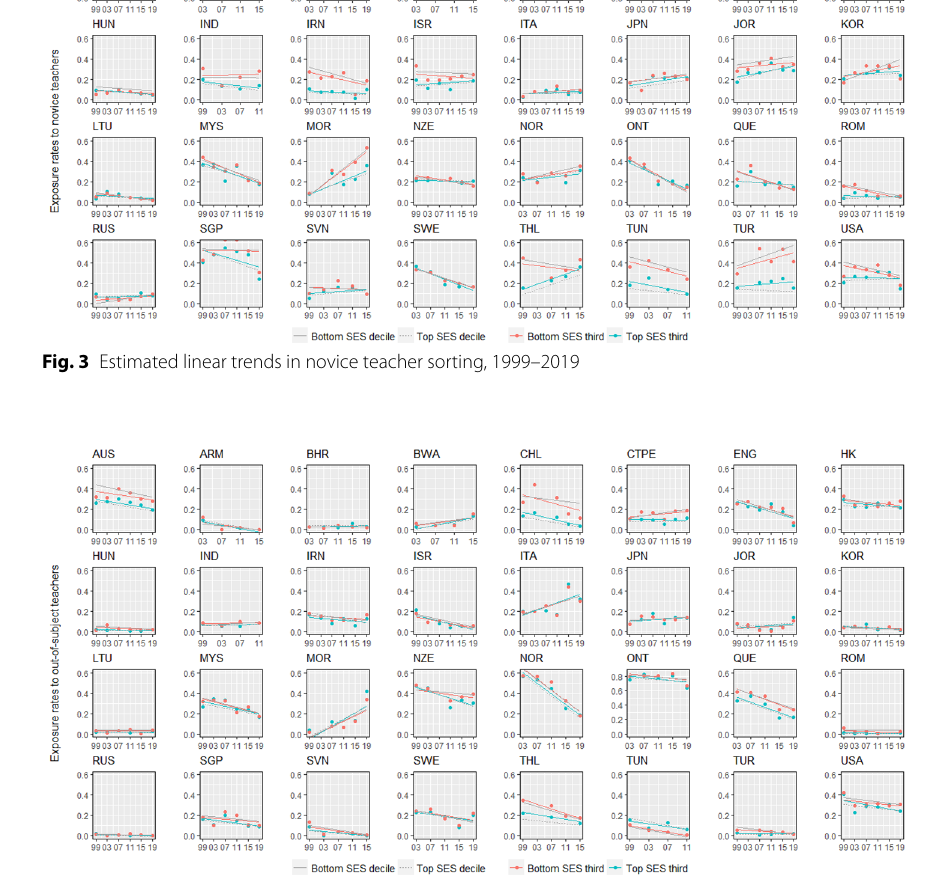
Fig. 4 Estimated linear trends in out-of-subject teacher sorting,